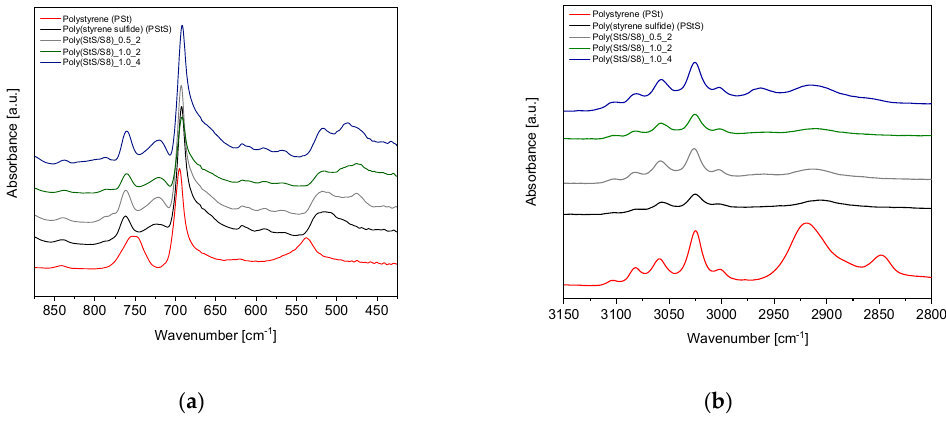
Figure 8. The FTIR spectra zoomed on ( a ) the spectral range characteristic for C–S and S–S stretching modes, ( b ) the spectral range including C–H stretching modes.